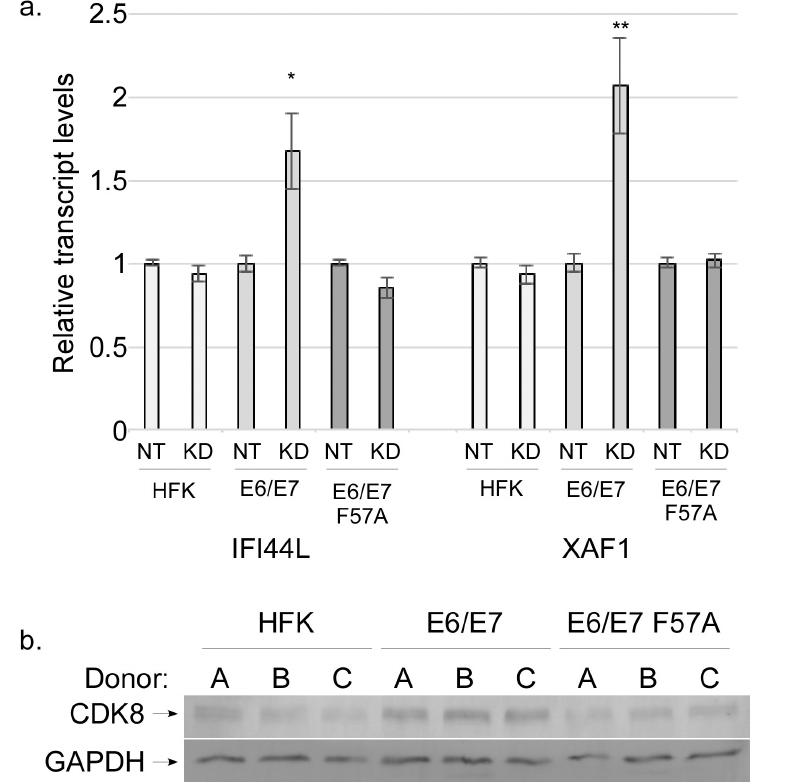
Figure 6. Effect of CDK8 knockdown on ISG levels. ( a ) RT-qPCR analysis of IFI44L and XAF1 transcript levels in non-target (NT) or CDK8 knockdown (KD) HFK, pLXSN E6/E7, and pLXSN E6/E7 F57A cells. Transcripts were normalized to cyclophilin A housekeeping gene with NTC values for each cell line set to 1. ( b ) Western blot analysis of CDK8 and GAPDH protein levels in HFK, pLXSN E6/E7, and pLXSN E6/E7 F57A cells from three HFK donor backgrounds.